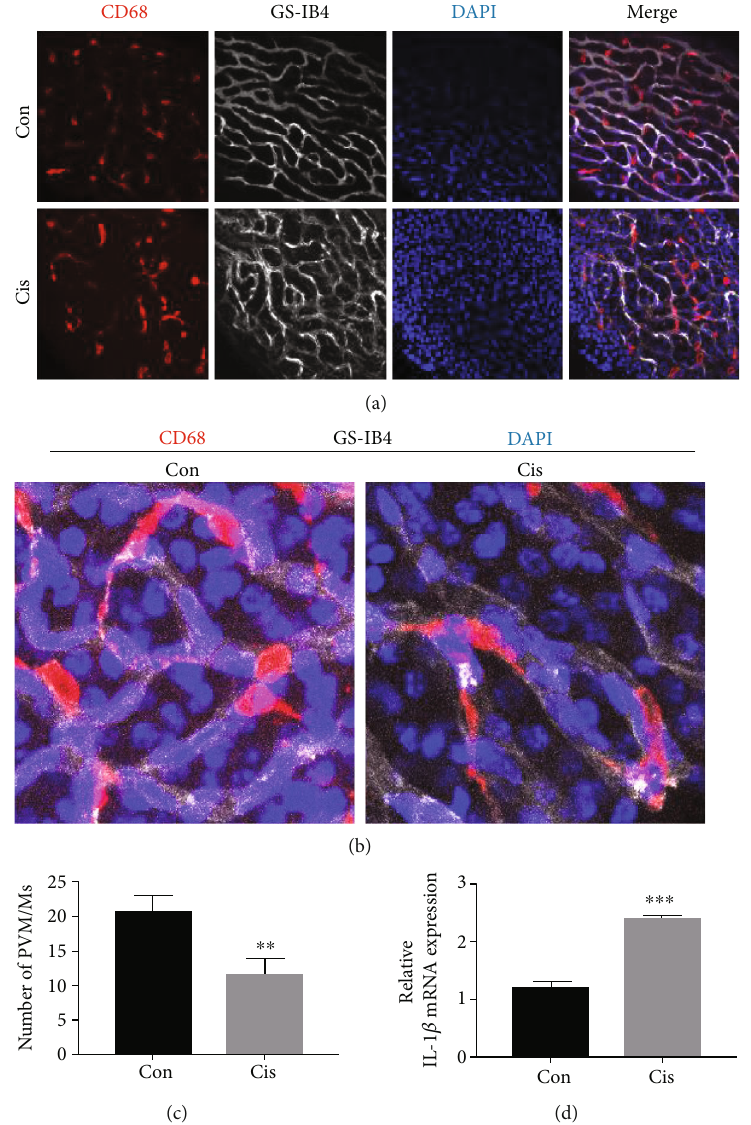
Figure 6: Cisplatin activates PVM/Ms in SV. (a) The distribution of PVM/Ms by immuno fl uorescence staining. PVM/Ms were marked with a special antibody against CD68 (red) and strial capillaries with Gri ff onia Simplicifolia IB4 (gray). Nuclei were stained with DAPI (blue). The PVM/Ms were highly invested on the abluminal surface of capillaries. Scale bars, 100 μ m. (b) Zoom in of immuno fl uorescence staining. (c) Quanti fi cation of CD68-positive in fi ltration per SV area ( n = 5 ). (d) qRT-PCR shows mRNA for IL-1 β in the SV. n = 6 . ∗∗ p < 0 : 01 and ∗∗∗ p < 0 : 001